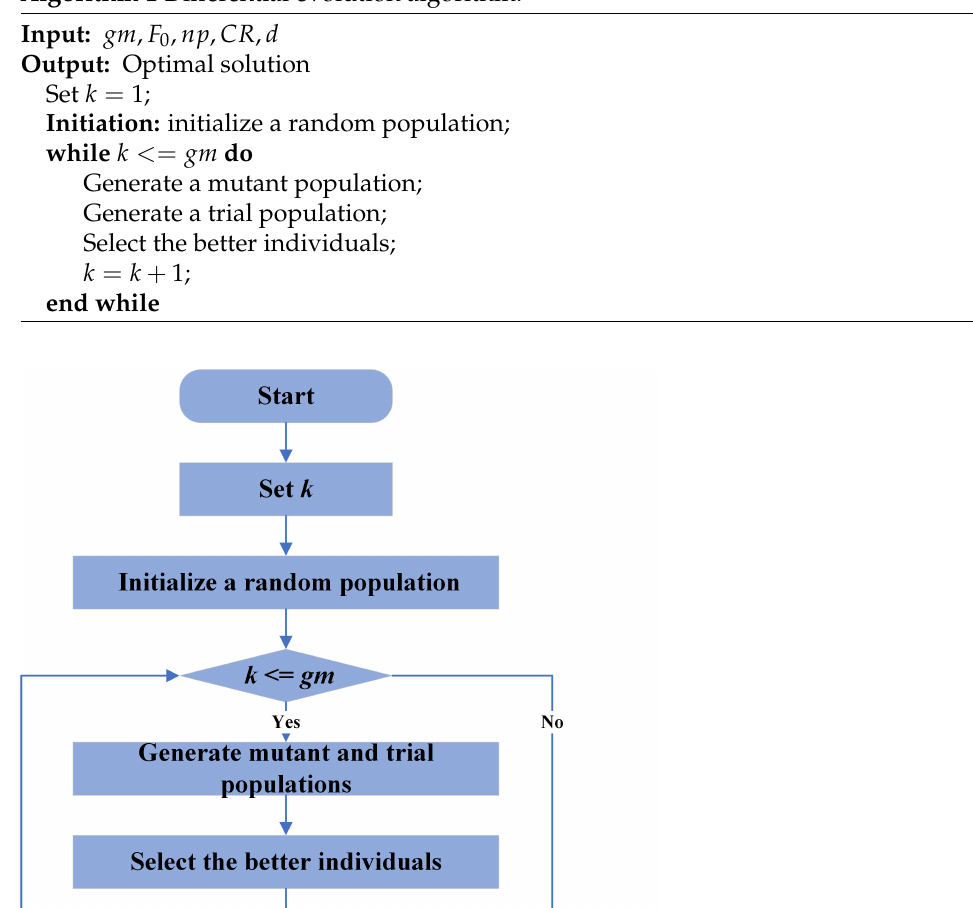
Algorithm 1 Differential evolution algorithm.